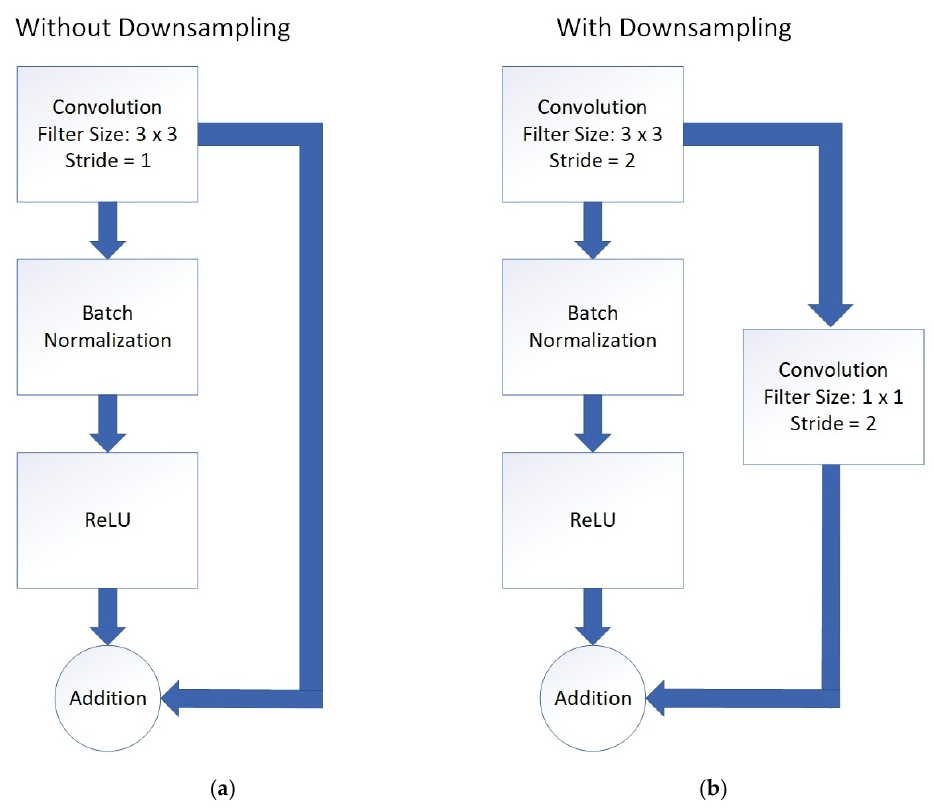
Figure 7. Application of addition layer to preserve information. ( a ) original residual block from ResNet; ( b ) modified residual block with downsampling.